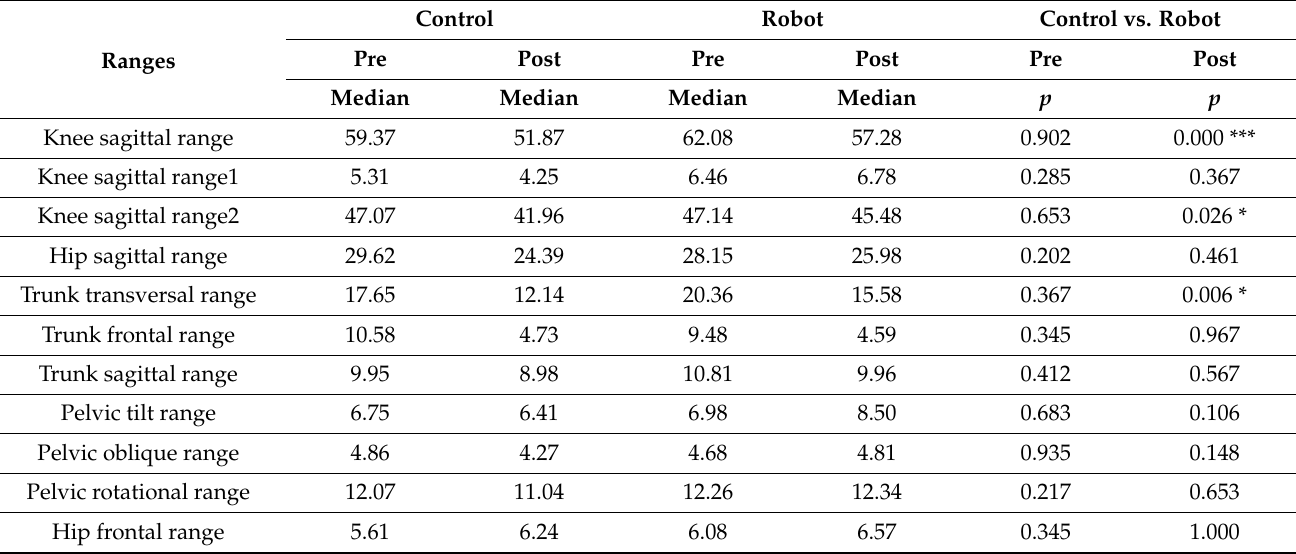
Table 3. Shows ranges (in ◦ ) of the gait analysis. A p value of <0.05 was defined as showing a significant difference, and a difference with a p value of <0.001 was considered highly